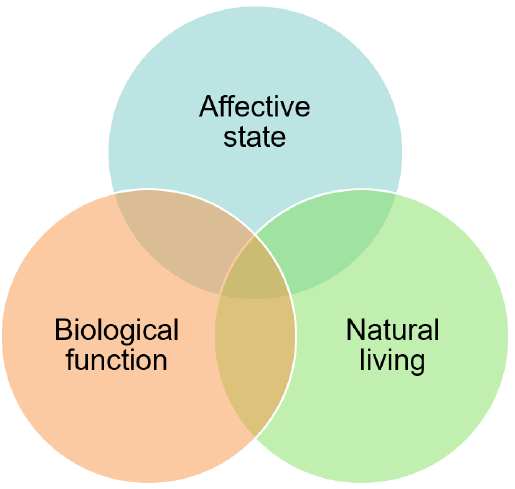
Figure 1. The animal welfare framework. Descriptions were developed by Fraser et al.